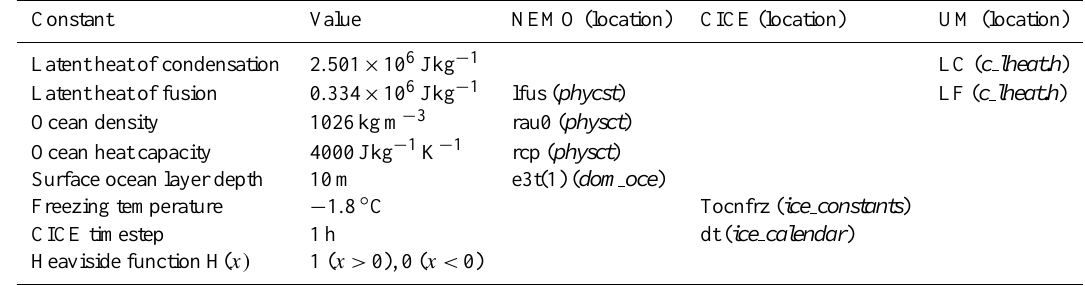
Table 1h. Table of constants as used in model components and coupling code relating to Fig. 4.